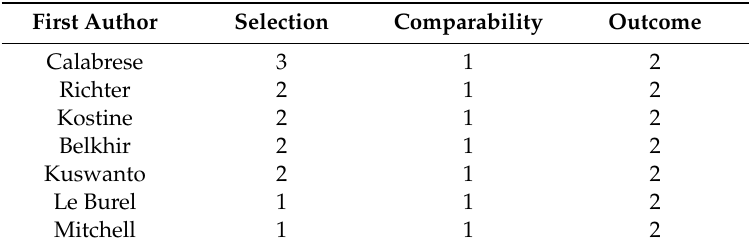
Table 3. Quality assessment of the included